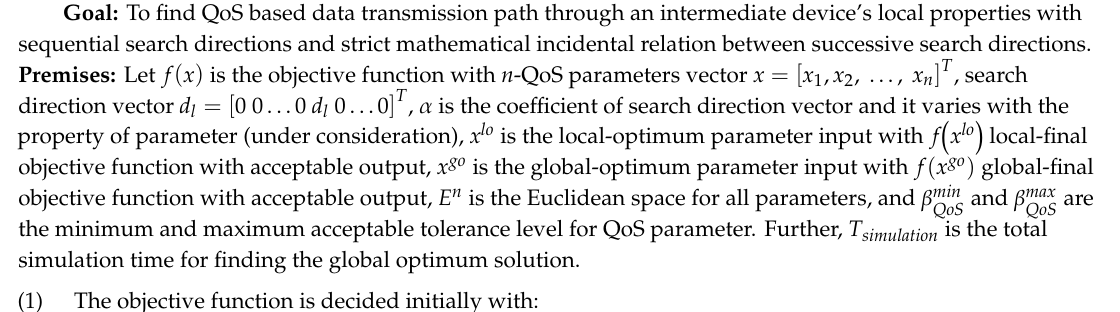
Algorithm 1: Proposed QoS-sequential Coordinate-descent Data Transmission Path Search